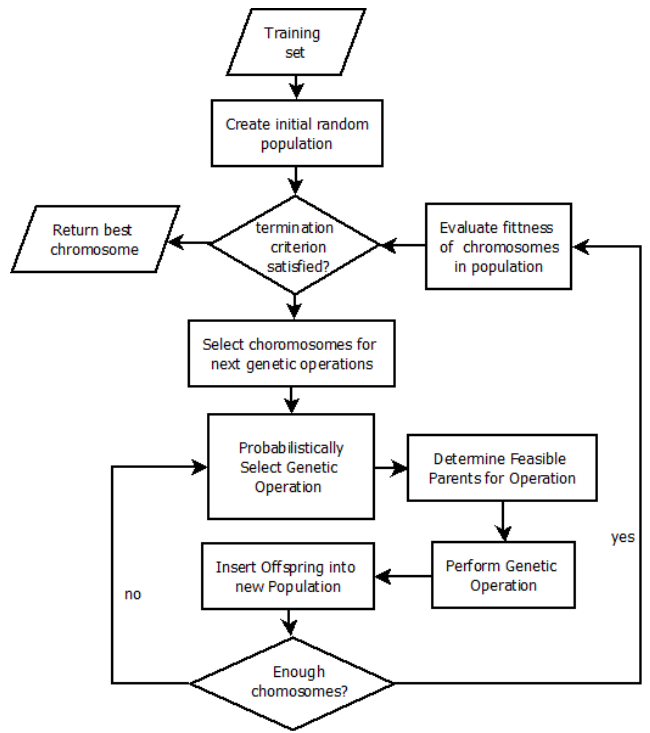
Figure 2. Flowchart for generating a semantic model using genetic